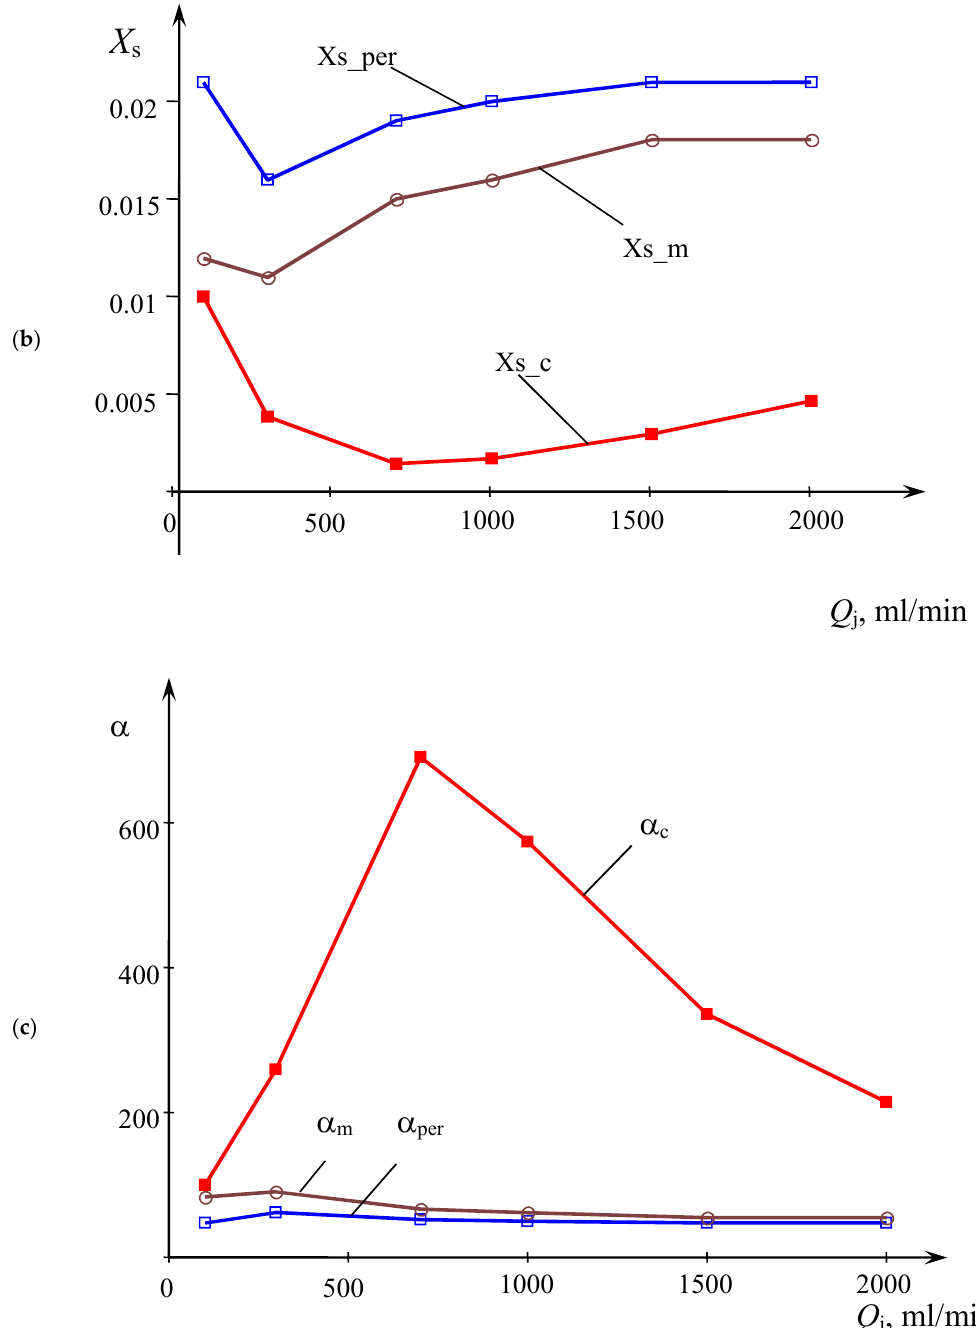
Figure 7. The dependence of the mass fraction of liquid samples collected in the center ϕ ( a ), the segregation coefficient X s ( b ), and the relative volume of ideal mixing α ( c ) on the jets flow rates Q j (ml/min) in MRFIJ (Figure 3, 2θ = 97.5°, d j = 1.0 mm, T = 21 °C) in samples: Xs_c, α c –in the center; Xs_per, α per –at the periphery; Xs_m, α m –weighted average. Figure 7b,c show the dependencies of segregation coefficient X s and the relative volume of ideal mixing α on the jets flow rates Q j , respectively.